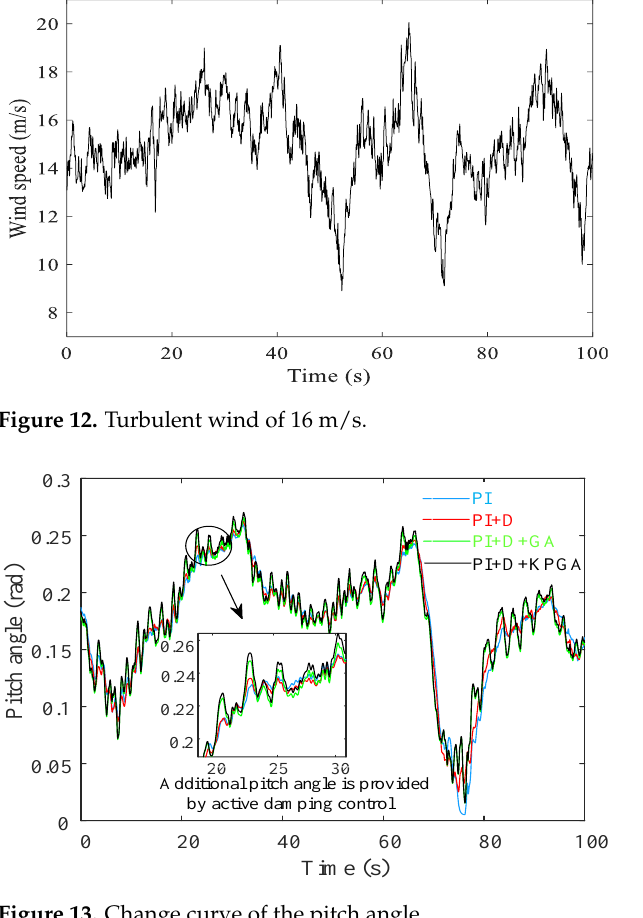
15 of 22 Figure 11. Self-power spectral density of the fore-aft acceleration for the tower top. 5.2. Time Domain Simulations